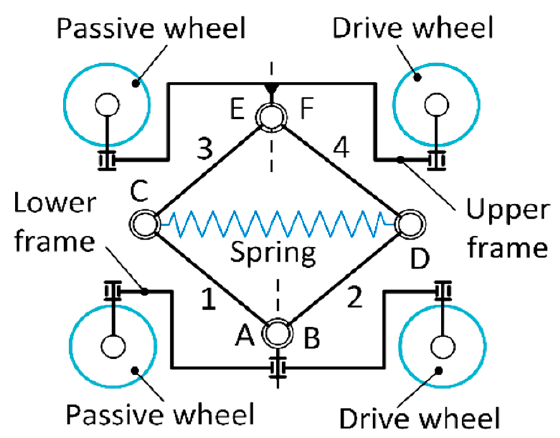
10 of 18 Figure 11. Inspection robot with pantograph linkage. The force produced by a spring determines the rotation of elements 1 and 2 around the joint D. This causes the expansion of the mechanism and therefore the increase of the wall pressing force. The lengths of elements 2 and 3 are 50 and 25 mm, respectively, the robot being able to inspect horizontal or vertical pipes with diameters between 50 and 70 mm. By using wider wheels, it was possible to increase the friction force and thus avoid slipping. As all wheels are in the same plane, the robot is not able to maintain its orienta- tion toward the inner walls of the pipe. The equation for determining the pressing force is available in [44]. Oya et al. in [45] present the development of a steerable in-pipe robot. The robot con- sists of two frames and a pantograph linkage that connects the centers of the two frames. The frames are identical, the wheels are independently steered, but the drive power is given only to the front wheels. Since the lower frame can rotate around the vertical axis, both frames can twist. This ability is useful for turning the robot around and avoiding obstacles. The proposed robot is able to move in three different ways: a straight line in which the wheel frames are parallel; a spiral movement in which the frames twist with a